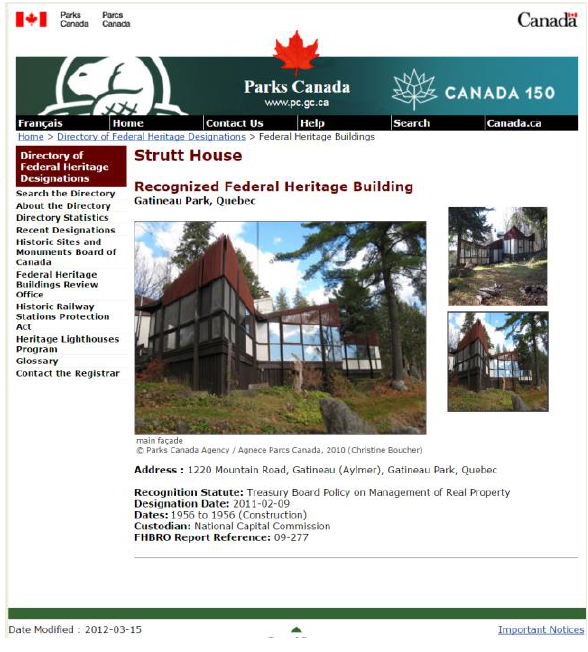
Figure 1. Screen capture of ©Parks Canada web page from their